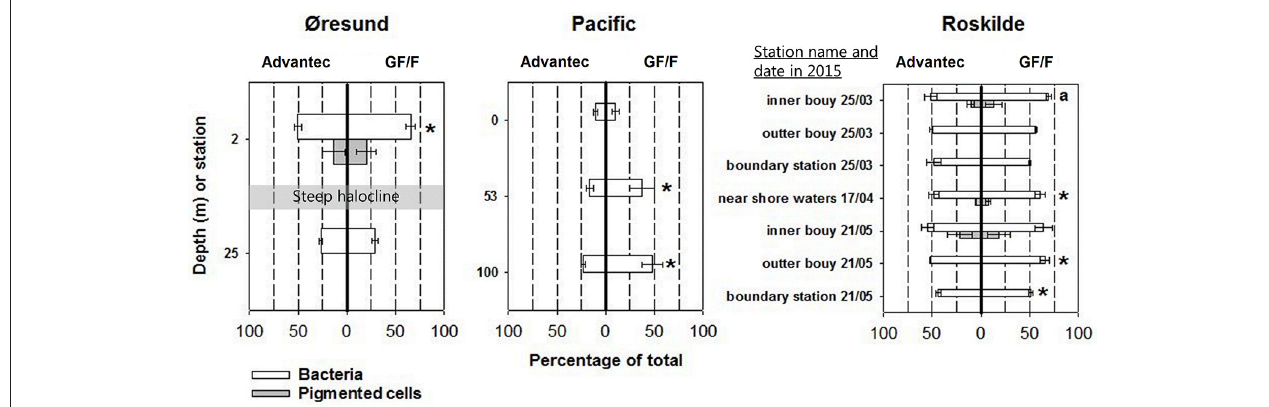
FIGURE 2 | Cell retention characteristics of Advantec and GF/F filters, illustrated as the percentages of cells found in filtrates relative to the cell abundances in bulk water samples (averages ± standard deviation, n = 3). The actual cell abundances can be found in Supplemental Table S1. Where gray bars are lacking, pigmented cells (which included some cells larger than the nominal pore size of the glass fiber filters) were completely retained by the filters or too low in abundance for reliable quantification. Cases where abundances were significantly different between the two filtrates are marked with asterisks ( t -test, p < 0.05). In Øresund, the halocline separates surface waters with a salinity of 11 and deep waters with a salinity of 33. For the inner buoy sample on 25th March 2015 (marked with an a) statistical differences could not be calculated since only two replicates were available for flow